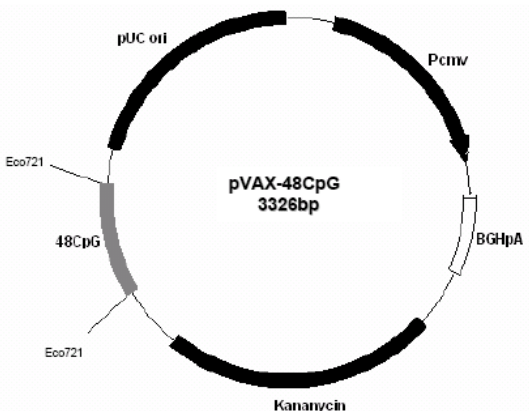
Figure 6. Plasmid